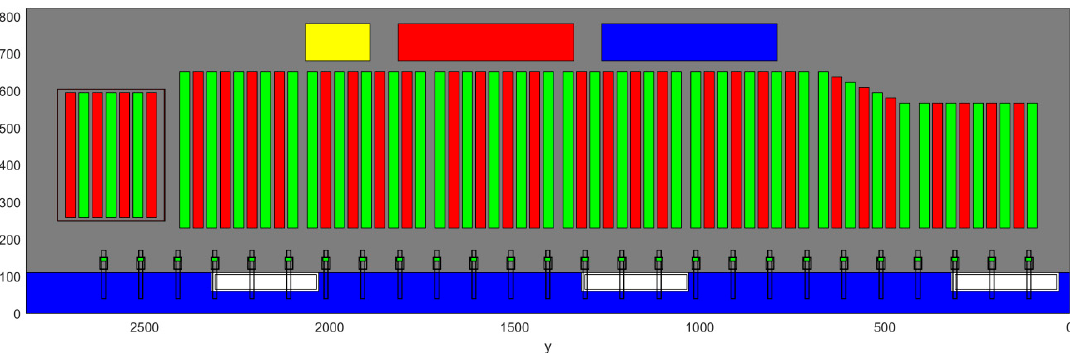
Figure 2. Simulation environment for phase IV wharf of Yangshan Port. In the middle of the figure, the areas with red and green stripes represent the container areas, while the areas inside the black wire frame on the left denote the dangerous container areas. In the upper part, the red and blue rectangular areas are the empty container yard area, and the yellow area is the port inspection area.